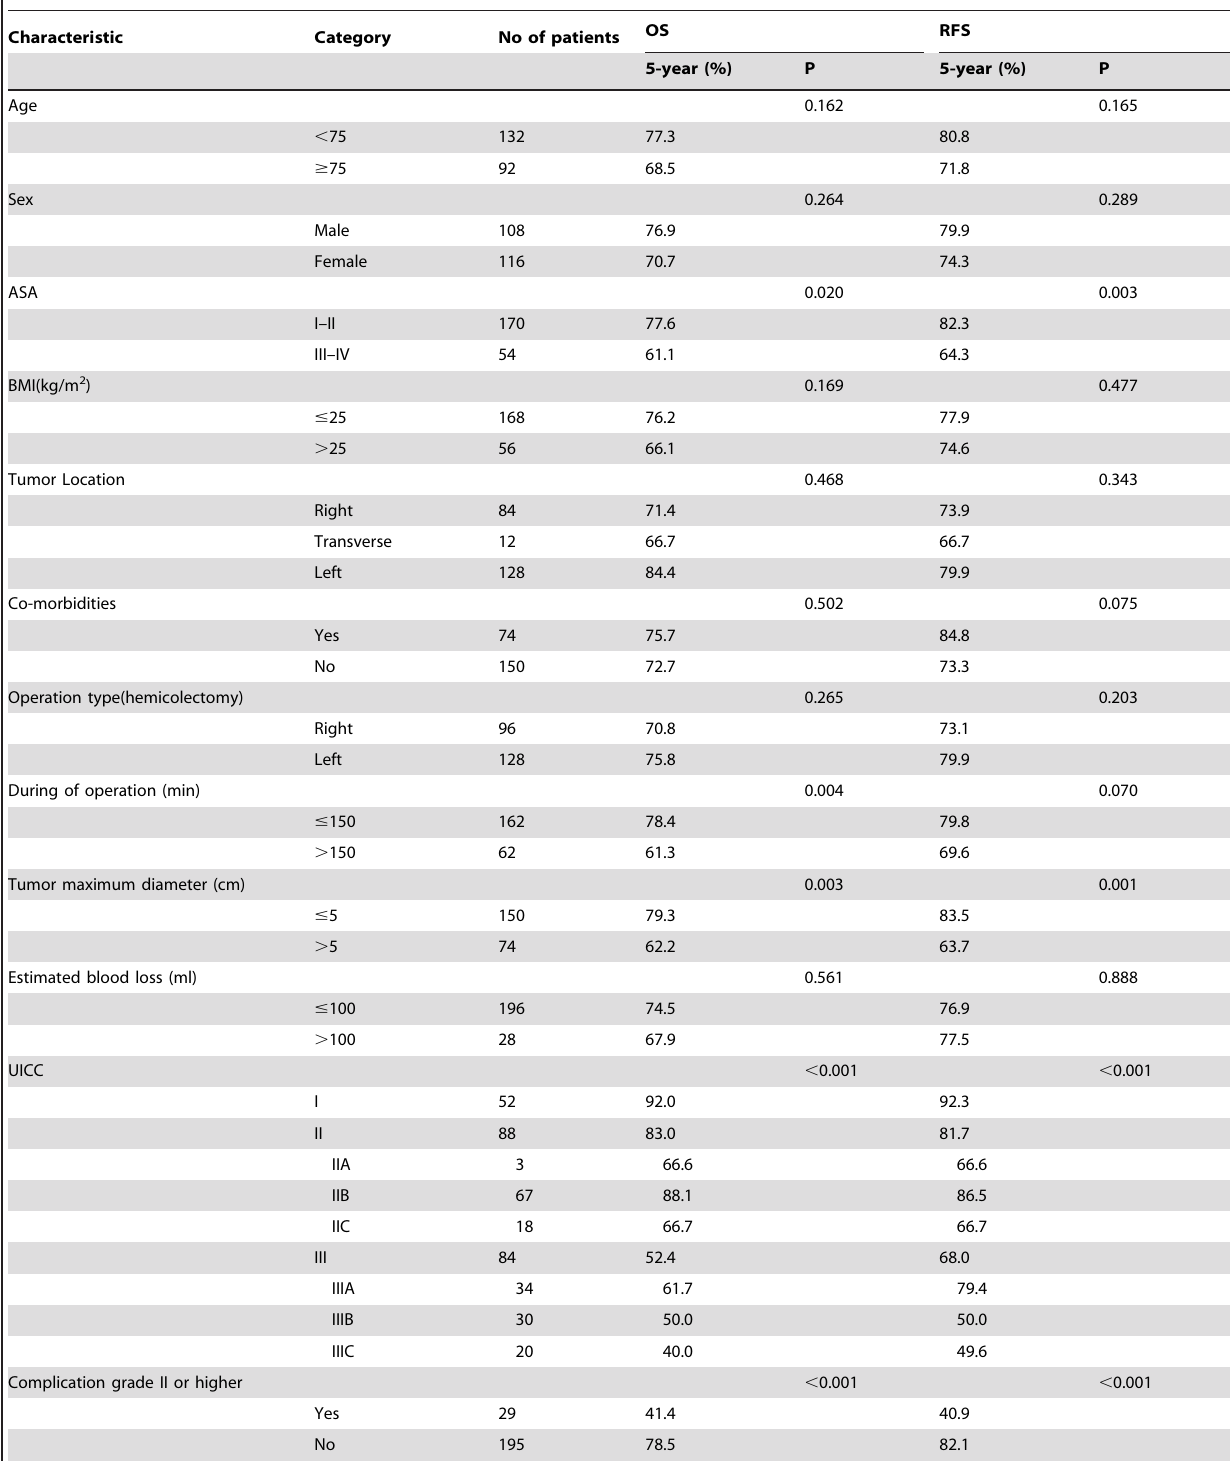
Table 2. Univariate analysis of prognosis factor for OS and RFS